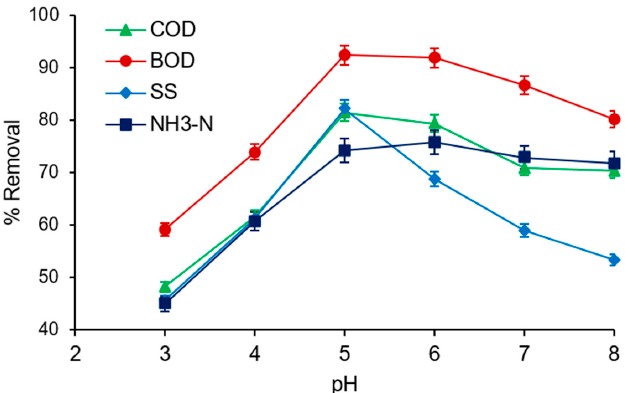
Figure 1. Influence of pH on the removal of COD, BOD, SS, and NH 3 from SRPE using FeSO 4 ·7H 2 O